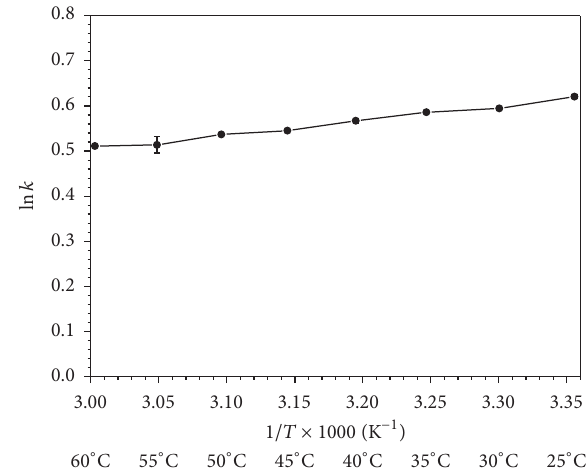
Figure 2: Van’t Hoff plot for MDA. The conditions were as follows: UPLC C 18 column; isocratic elution, mobile phase con- taining acetonitrile-water with 0.1% (v/v) formic acid; flow rate 0.1 mLmin −1 ; MDA concentration 100 𝜇 g L −1 ; injection volume 10 𝜇 L.